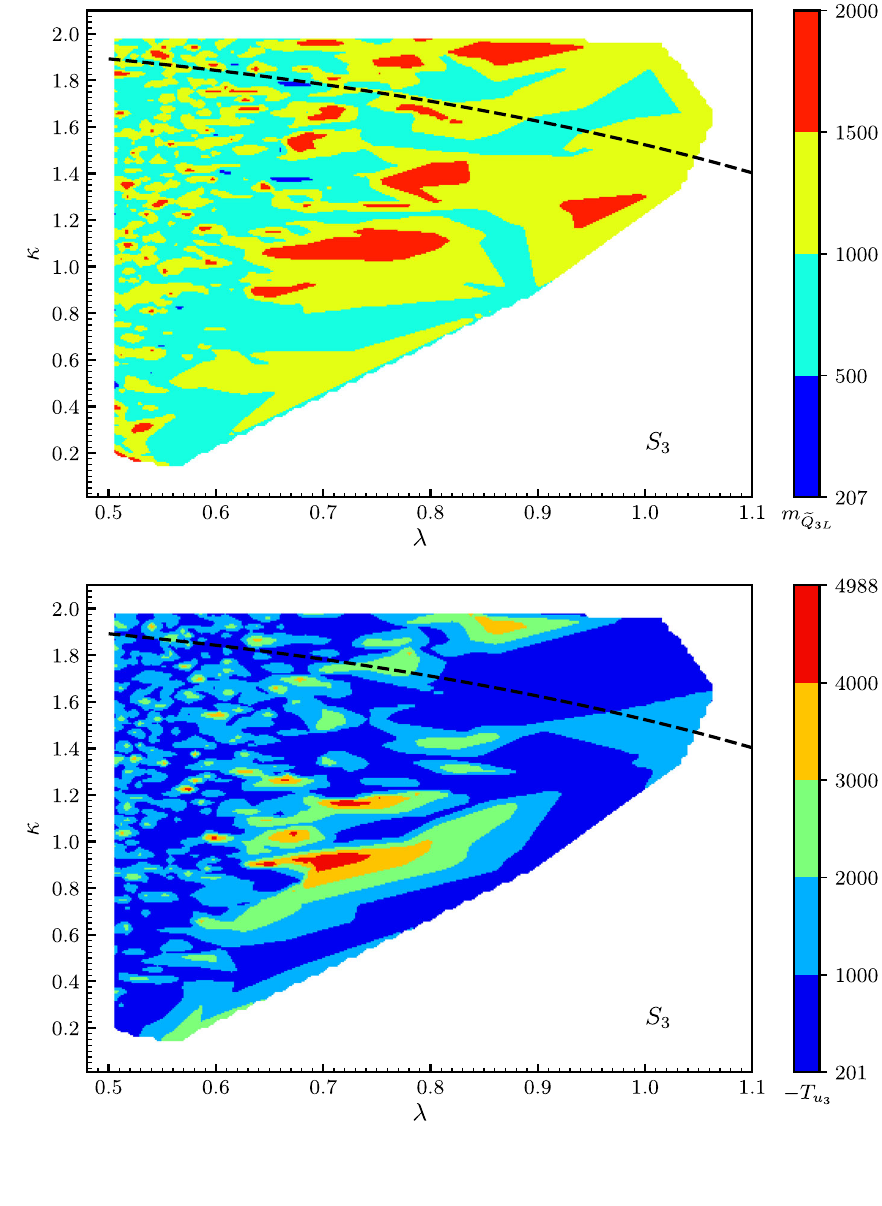
Fig. 36 The same as in Fig. 32, but the colours indicate different low-energy values of the soft masses m (cid:6) Q 3 L